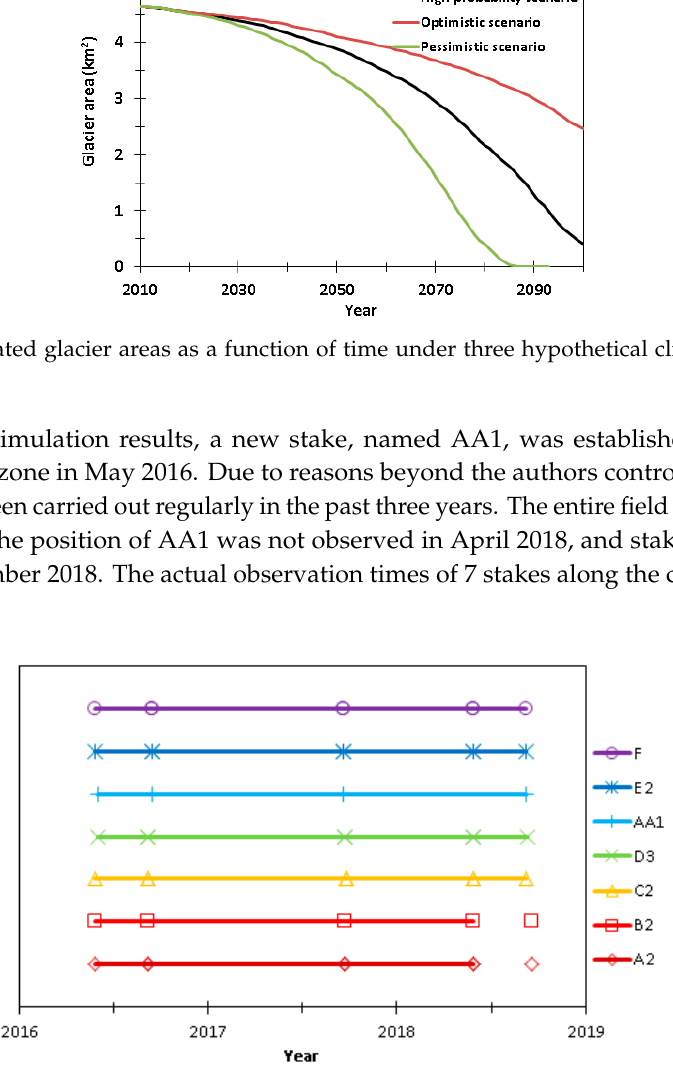
Figure 10. The comparison of the simulated and measured (May 2016-Sep., 2018) velocities (m/a) of 7 stakes along the central flow line. The different colors denote measured or simulated measurements. 4. Discussion In contrast to Kronebreen, which is the largest glacier in Ny-Alesund and has a mean ice flow velocity of 600 m/a at the glacier front [11], AL moves very slowly. However, compared to Pedersenbreen and ML, which are also valley glaciers and just next to AL, AL has similar ice flow velocities [1,21]. The seasonal change of the ice flow velocity is one of the most essential characteristics for the glaciers in Svalbard. For ML, the short-term velocity variations can be found during July and August